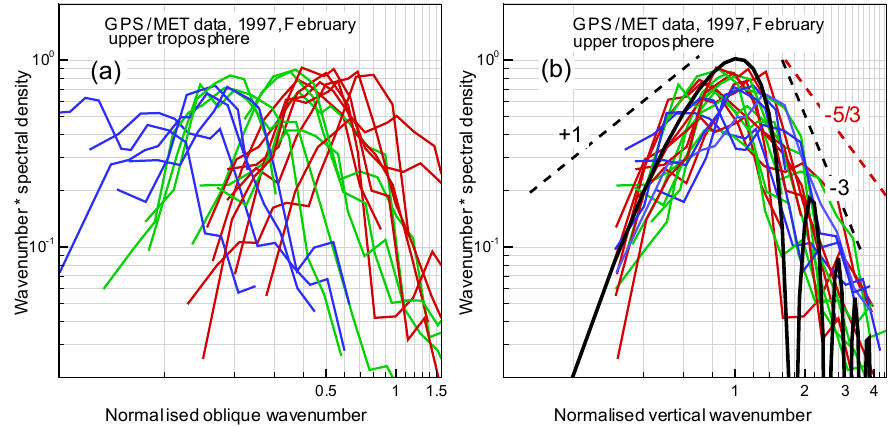
Figure 3. Amplitude fluctuation spectra for the upper troposphere: (a) spectra as functions of the oblique wave number corresponding to the isotropy hypothesis (Kolmogorov turbulence); (b) spectra as functions of the vertical wave number corresponding to the anisotropy hypothesis (saturated IGWs). The notations are the same as in Fig.